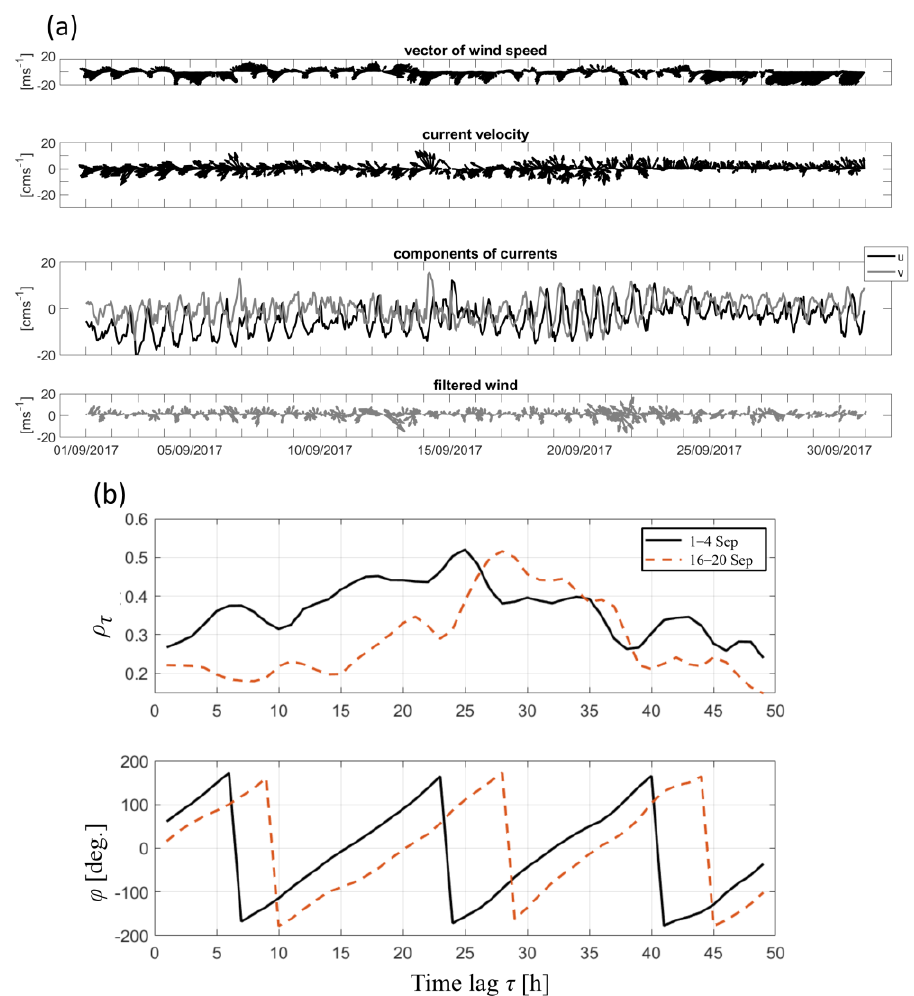
Figure 12. ( a ) Top—wind speed U ( t ) vector plot from the ERA-5 meteorological reanalysis data. The second plot from the top is the current velocity u ( t ) at 100 m at ABS No. 1 in September 2017, and the third plot from the top shows the u - and v -components of the current velocity. Bottom—wind speed after band-pass filtering for 22–26 h. ( b ) Top—lagged correlations ρ τ between the wind and current vectors for 1–4 and 16–20 September 2017, bottom—the angle ϕ of rotation of the current velocity vector relative to the wind velocity vector.